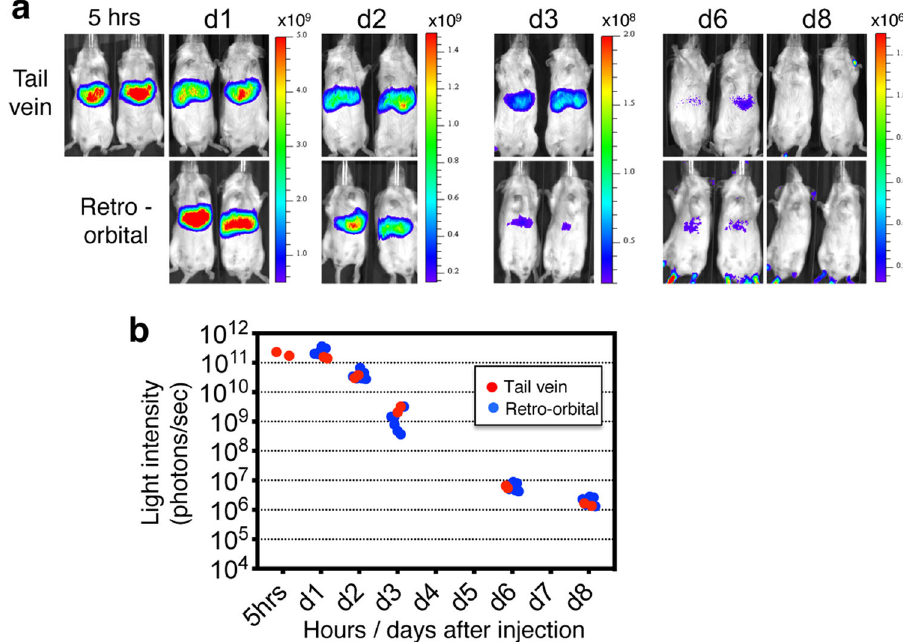
Fig. 1 A single IV injection of Luc mRNA-LNP induces robust and restricted luciferase activity in liver. a Images of bioluminescence measurement from 5 h, day1 (d1) up to day 8 (d8) following tail vein ( n = 2 mice) or retro-orbital ( n = 6 mice) injection of Luc mRNA-LNP. Scales represent light intensity in photons/sec. b Quanti fi cation of light intensity (photons/sec) over time. Each dot represents one mouse. Source data are provided as a Source Data fi